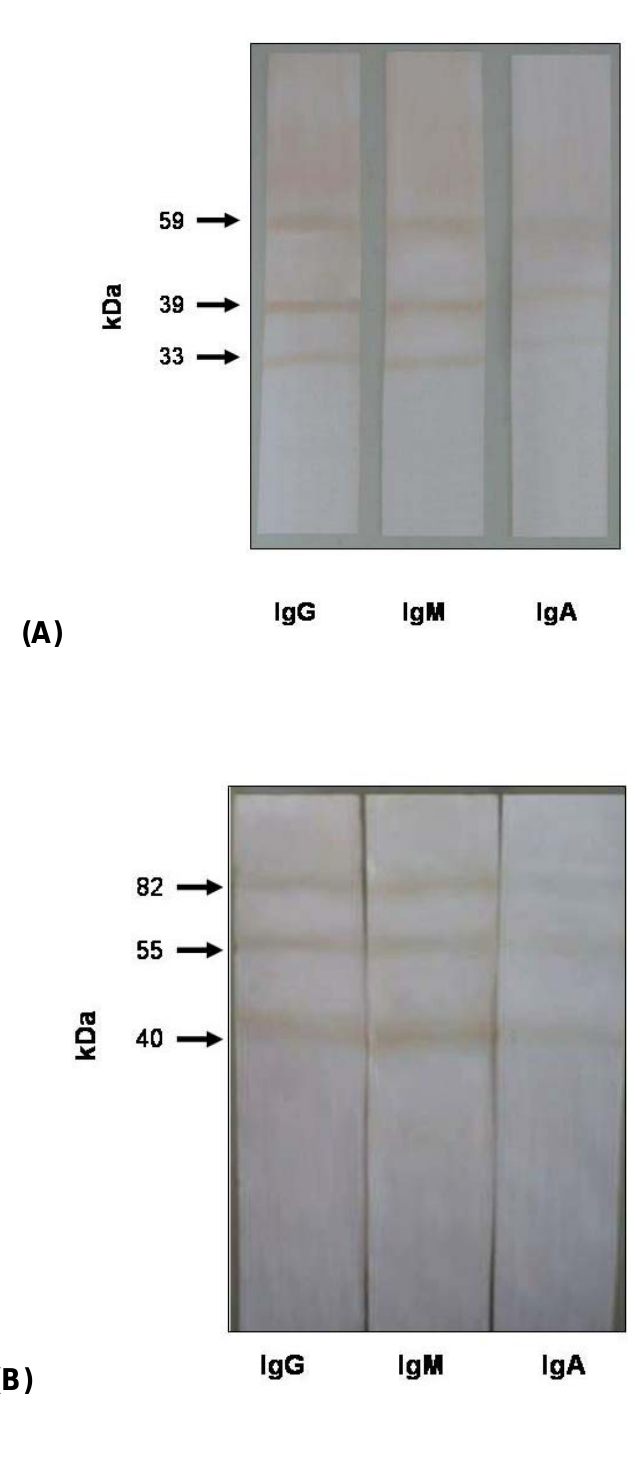
Figure 3. Immunoblot of both exoantigen (A) and cytoplasmic (B) extracts of T. mentagrophytes . Immunodominant IgG, IgM and IgA fractions are indicated by arrows and are expressed as